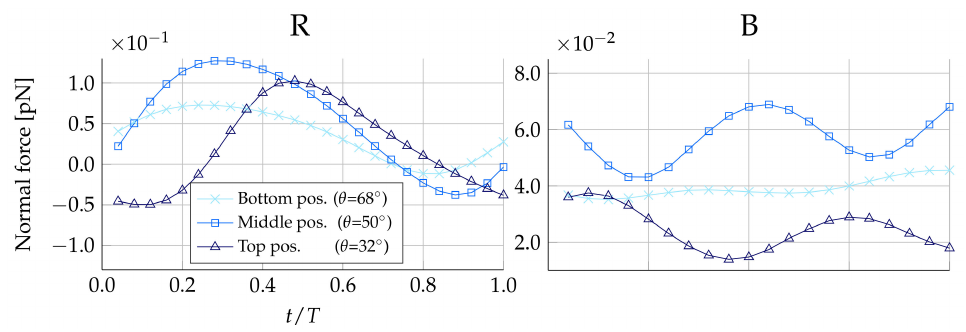
Figure 6. Normal force distribution on medium-sized prey during one beat cycle with period T . Here, negative forces are orientated in the direction away from the collar. Both plots are simulated without the presence of the lorica. The left-hand plot shows the forces on prey placed on the right (R) side of the collar, and the right-hand plot shows forces on prey placed at the back (B) of the collar. Table 4. Minimum contact force between microvilli tentacles and prey required to counteract the simulated hydrodynamic normal forces in the non-loricate D. grandis . Prey Prey Prey Prey s m l e Min. contact force